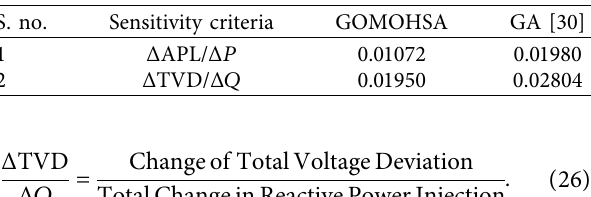
Table 16: Parameter sensitivity of GOMOHSA and